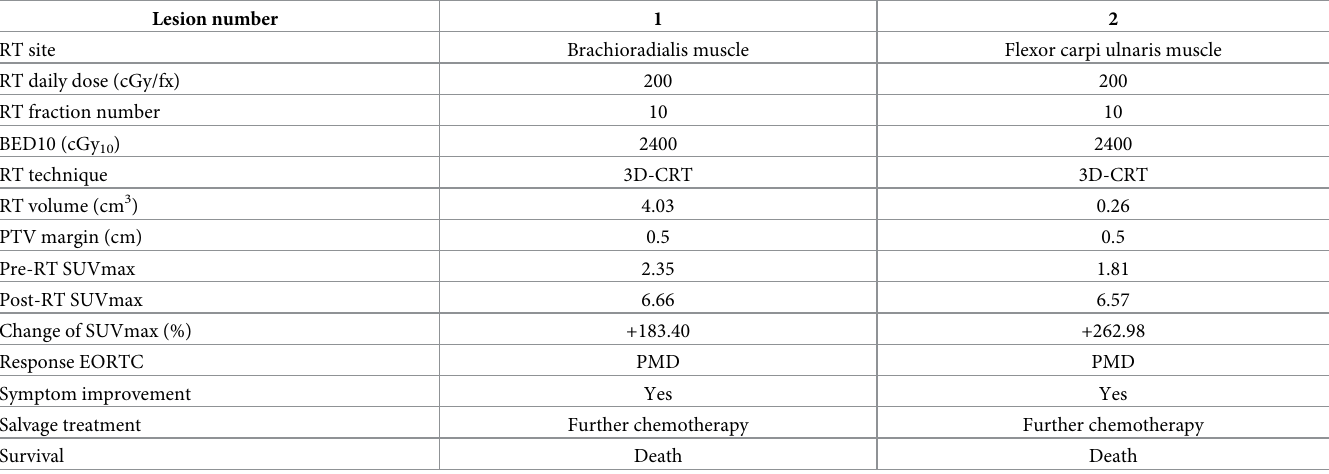
Table 3. Characteristics of progressive metabolic lesions after radiotherapy. Lesion number 1 2 RT site Brachioradialis muscle Flexor carpi ulnaris